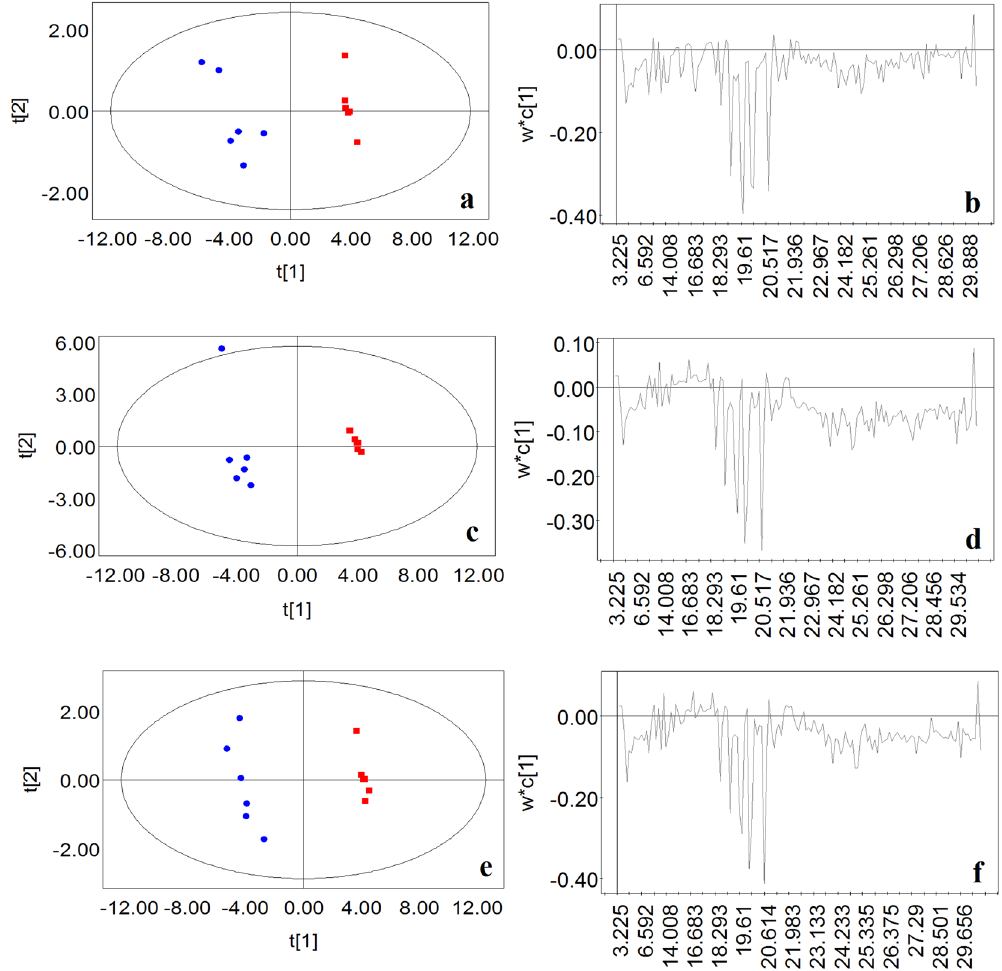
Figure 2. PLS-DA model plots for the control group (red symbols) versus the groups treated with different concentrations of TCBPA (blue symbols). Cross-validated score plots of the pairwise comparison between the ( a ) control versus 25 μ M, ( c ) control versus 50 μ M, and ( e ) control versus 100 μ M TCBPA-treated groups. Two groups in each score plot were separated along the first component. In the score plots, the confidence interval is defined by the Hotelling’s T2 ellipse (95% confidence interval), and observations outside the confidence ellipse are considered outliers. Loading plots of the pairwise comparison between the ( b ) control versus 25 μ M, ( d ) control versus 50 μ M, ( f ) control versus 100 μ M TCBPA-treated groups. The metabolites with the largest intensities contributed to the